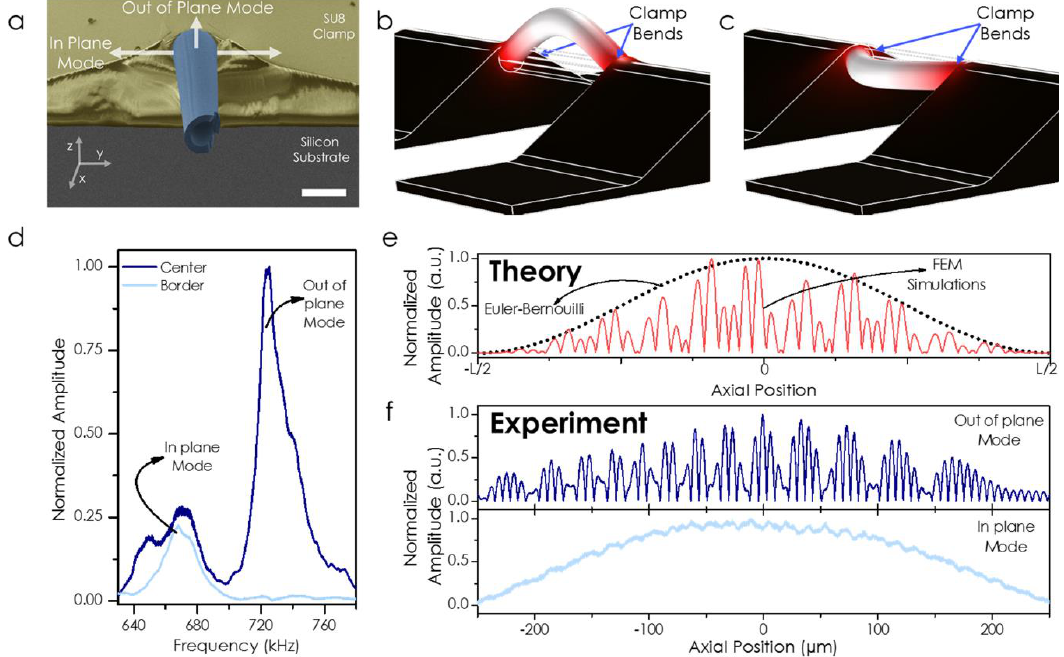
Figure 3. ( a ) Scanning electron microscope image (in false color) of the cross section of the fabricated device. The SU8 pads (in yellow) are not isotropic; therefore, there is a difference in the effective stiffness of the two orthogonal directions, labeled in the images as in-plane and out-of-plane modes. The scale bar is 50 µ m. ( b ) Simulations by using Finite Element Method (FEM) of the out-of-plane mode. ( c ) Simulations by using Finite Element Method (FEM) of the in-plane mode. ( d ) Experimental measurement of the mechanical spectrum at two different positions: at the capillary axis (dark blue curve) and at one side (light blue curve). ( e ) Expected mechanical amplitude mode profile for the fundamental mechanical mode, out-of-plane mode. ( f ) Experimental demonstration of the modulation in the amplitude mode profile for the out-of-plane mode (dark blue curve) and the in-plane mode (light blue